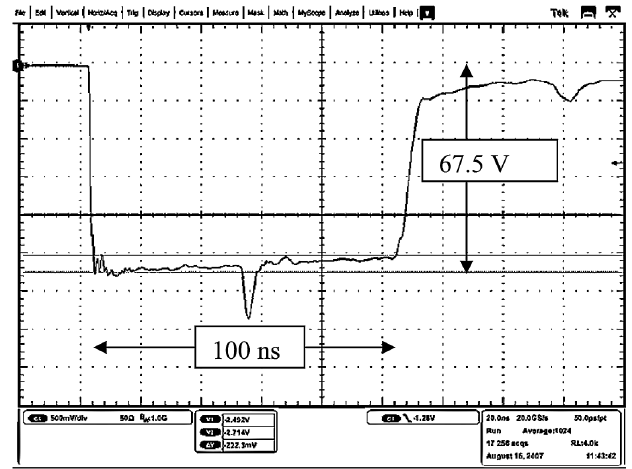
FIG. 2. The pulsed voltage signal between the grid and cathode when the perturbation cable is connected to the